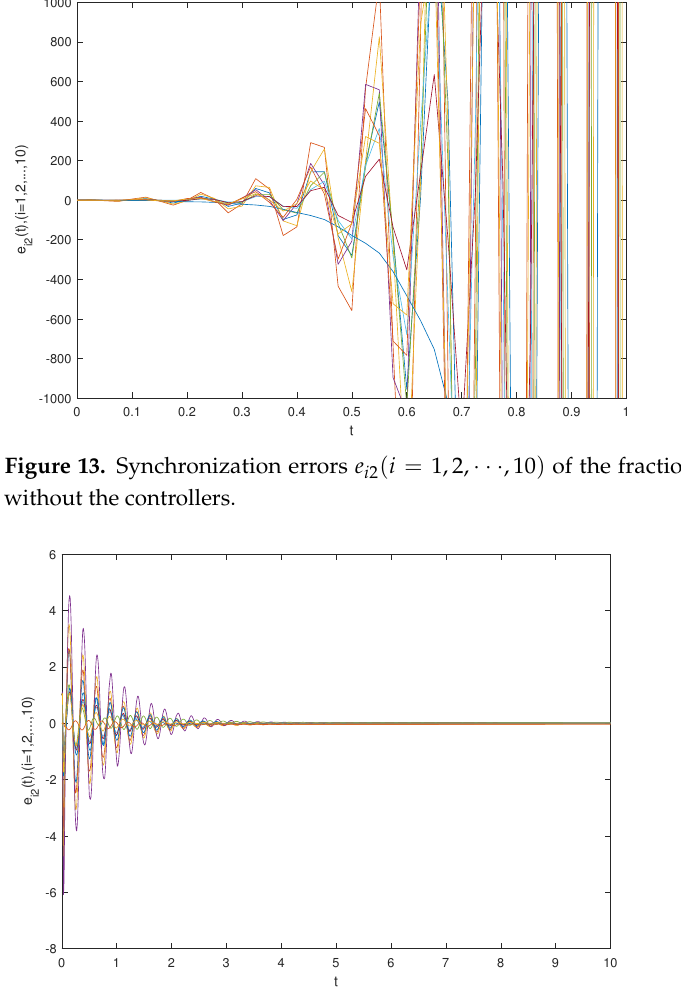
Figure 14. Synchronization errors e i 2 ( i = 1,2, · · · ,10 ) of the fractional-order system (34) and (35) with the controllers.